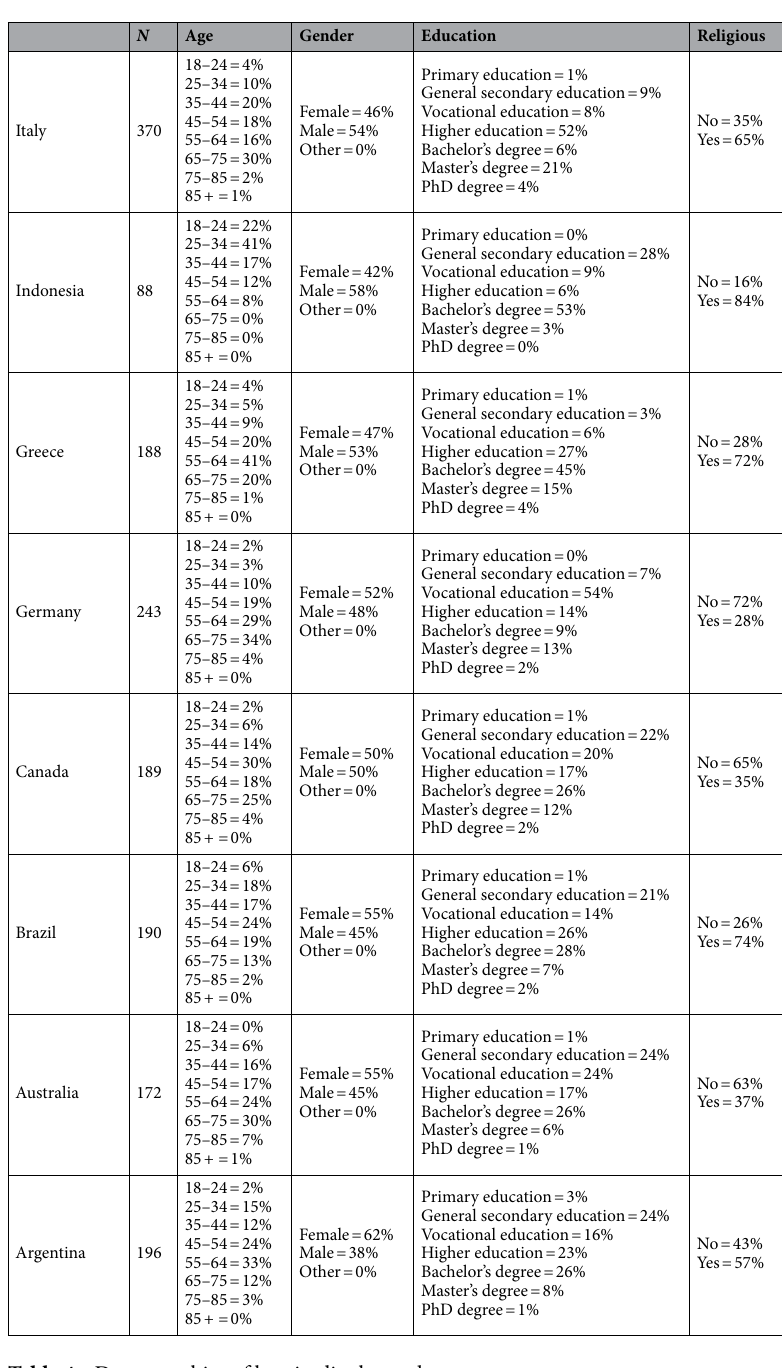
Table 4. Demographics of longitudinal